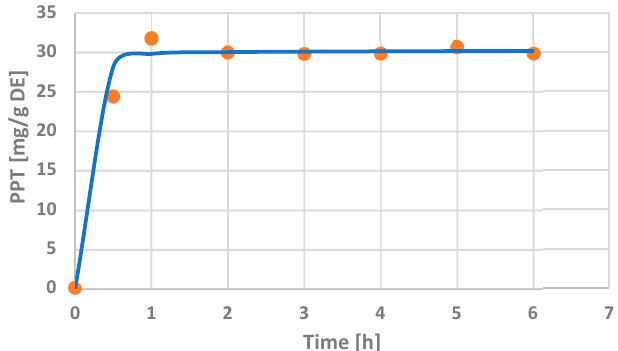
Figure 4. Effect of the extraction time on the PPT concentration in J. virginiana leaf extracts and correlation of Peleg’s equation curve (line) with the experimental data (points). Variable parameter—extraction time; constant parameters (previously selected conditions)—solvent ethyl acetate, room temperature and liquid-to-solid ratio of 10 ( v / w ). Abbreviations: PPT—podophyllotoxin; DE—dry extract.